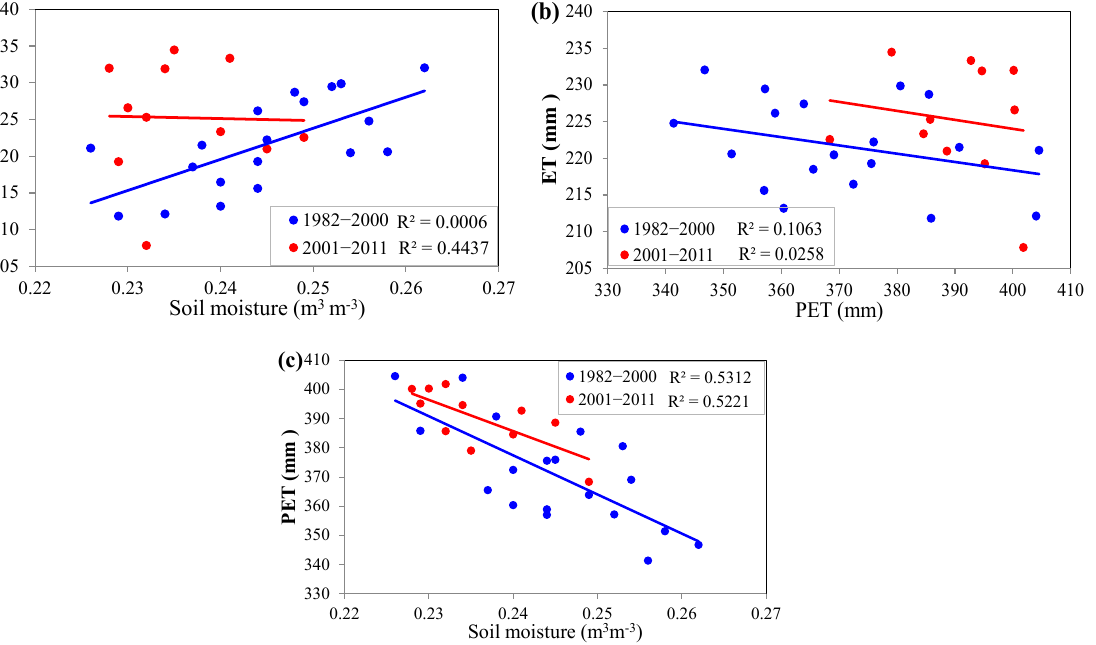
Figure 9. The scatter plots between regional-mean ET and soil moisture ( a ) and PET ( b ), and between PET and soil moisture ( c ).